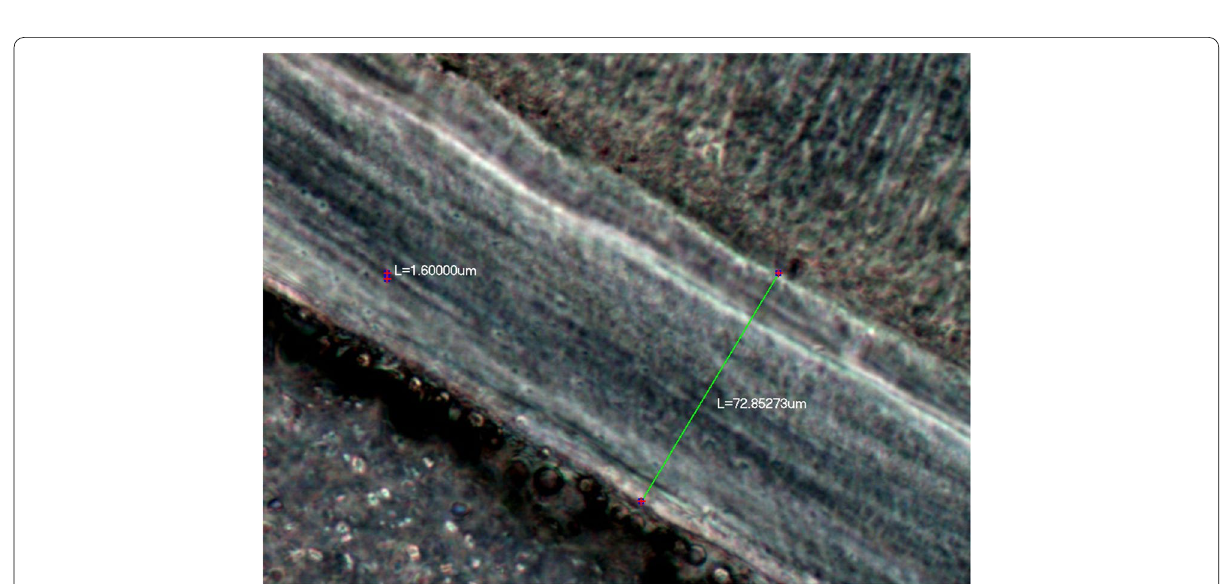
Fig. 2 Photomicrograph of periodontally diseased tooth showing measurement of the total width of cementum (ground section